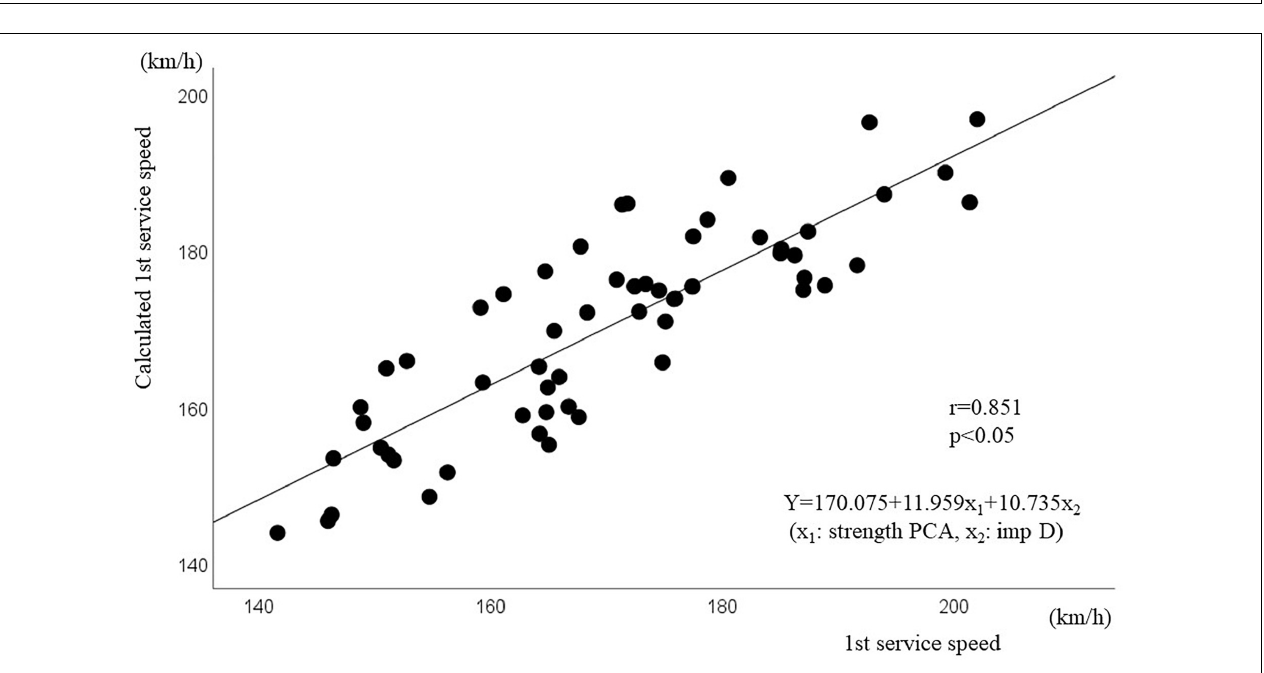
FIGURE 3 | Correlation analysis between the measured first service speed and calculated service speed Estimated formula from strength PCA and